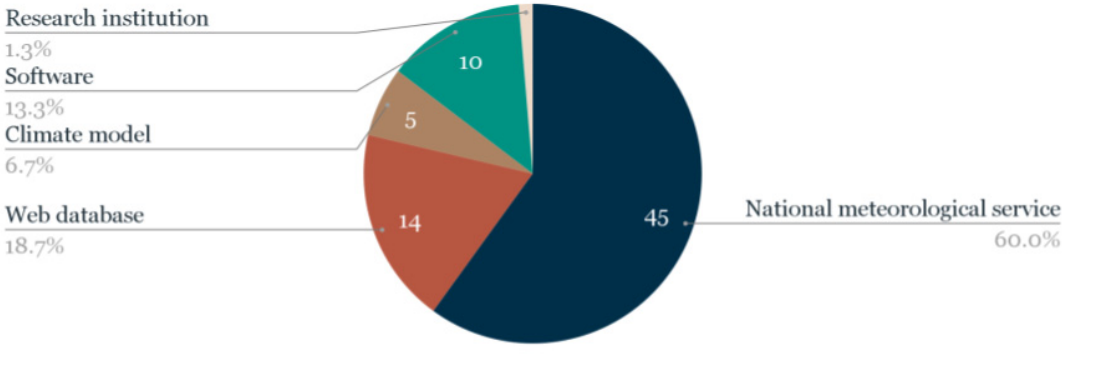
Monthly mean values, TMY, daily mean and hourly values are four primary data forms.